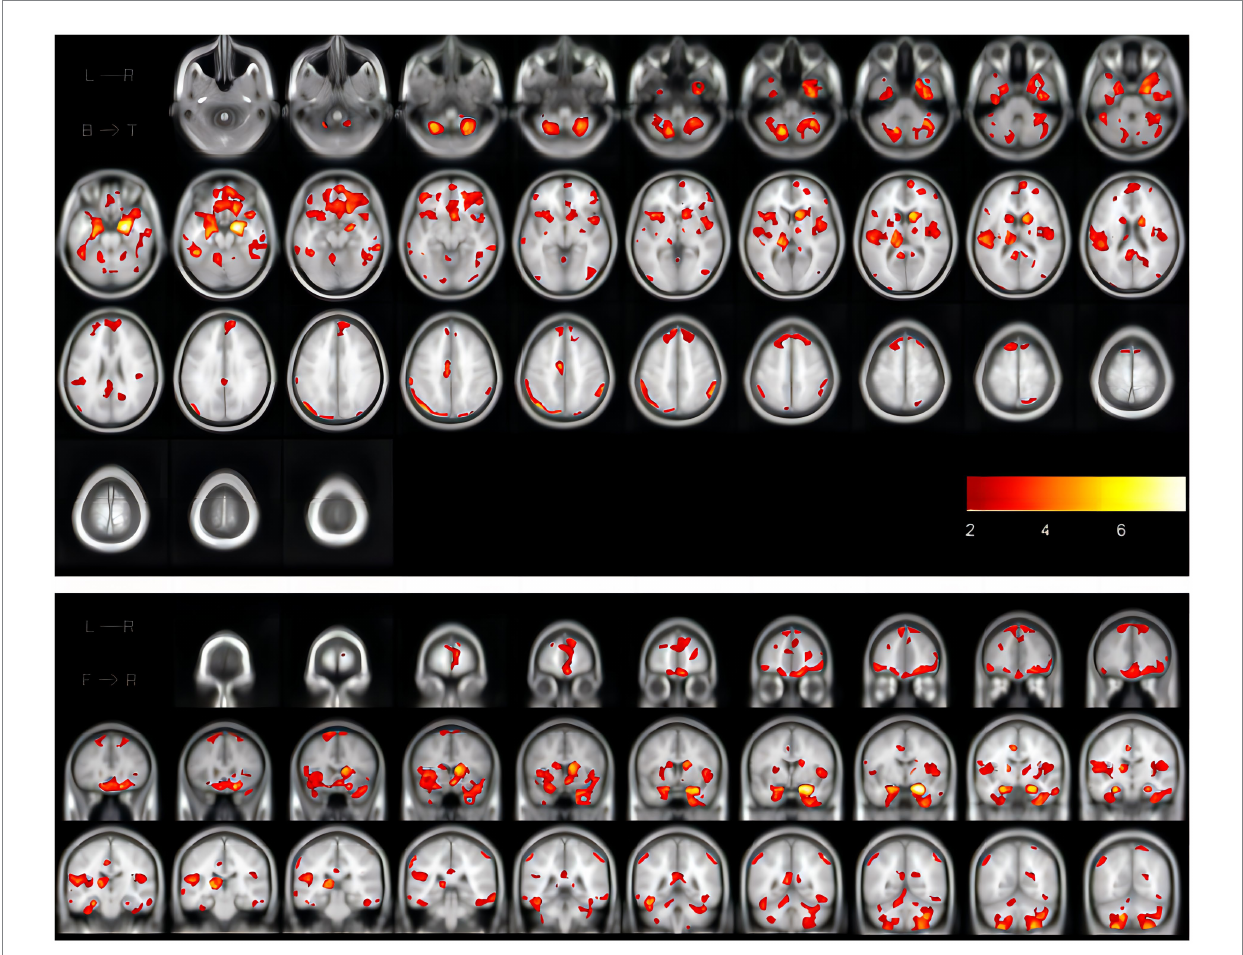
FIGURE 2 The coronal and cross-sectional images showing the results of white matter segmentation of one iNPH patient using the LST toolbox, in which the WMH is the marked yellow area in the figure. iNPH, idiopathic normal pressure hydrocephalus; LST, Lesion Segmentation Tool; WMH, white matter